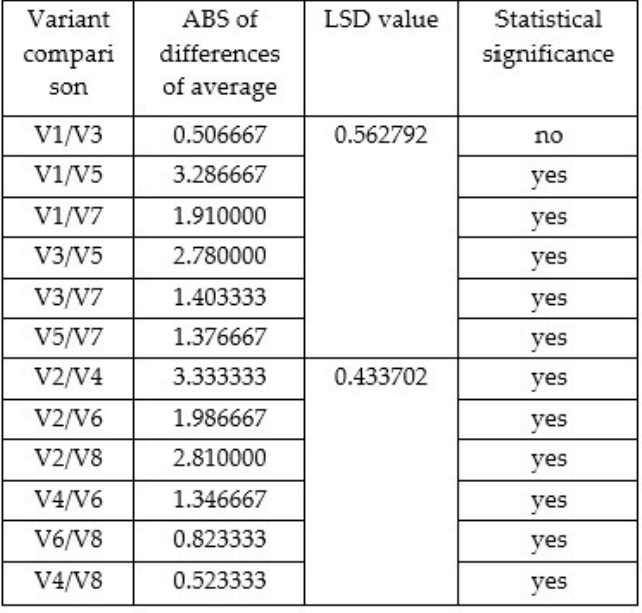
Figure 7. The statistical significance determined by LSD (Least Significant Difference) test values of Lepidium sativum L. sprouts’ length on gauze (V1 control, illuminated with sunlight; V3, illuminated with white LED; V5, illuminated with blue LED; and V7, illuminated with red LED experimental variant) or biochar (V2 control, illuminated with sunlight; V4, illuminated with white LED; V6, illuminated with blue LED; and V8, illuminated with red LED experimental variant), t crit value = 1.980626.